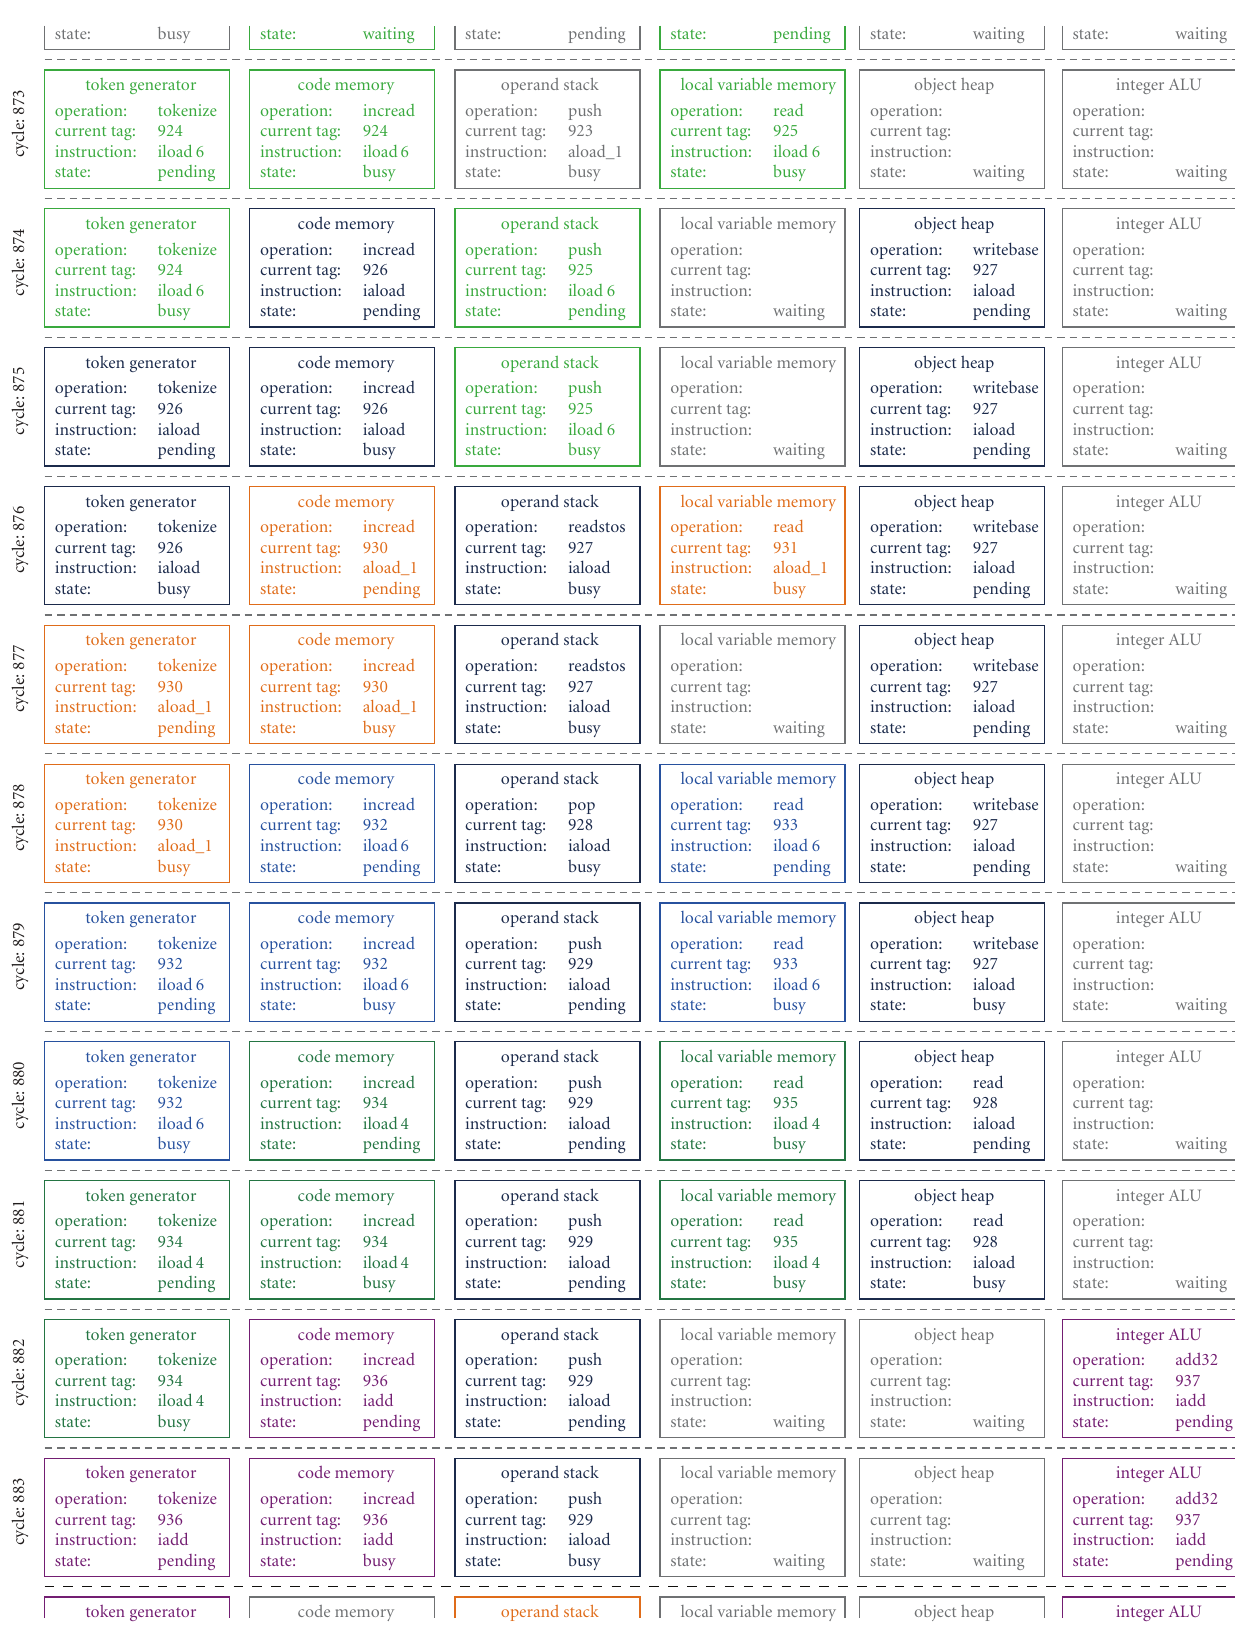
Figure 4: Visualized excerpt of an execution trace of the autocorrelation